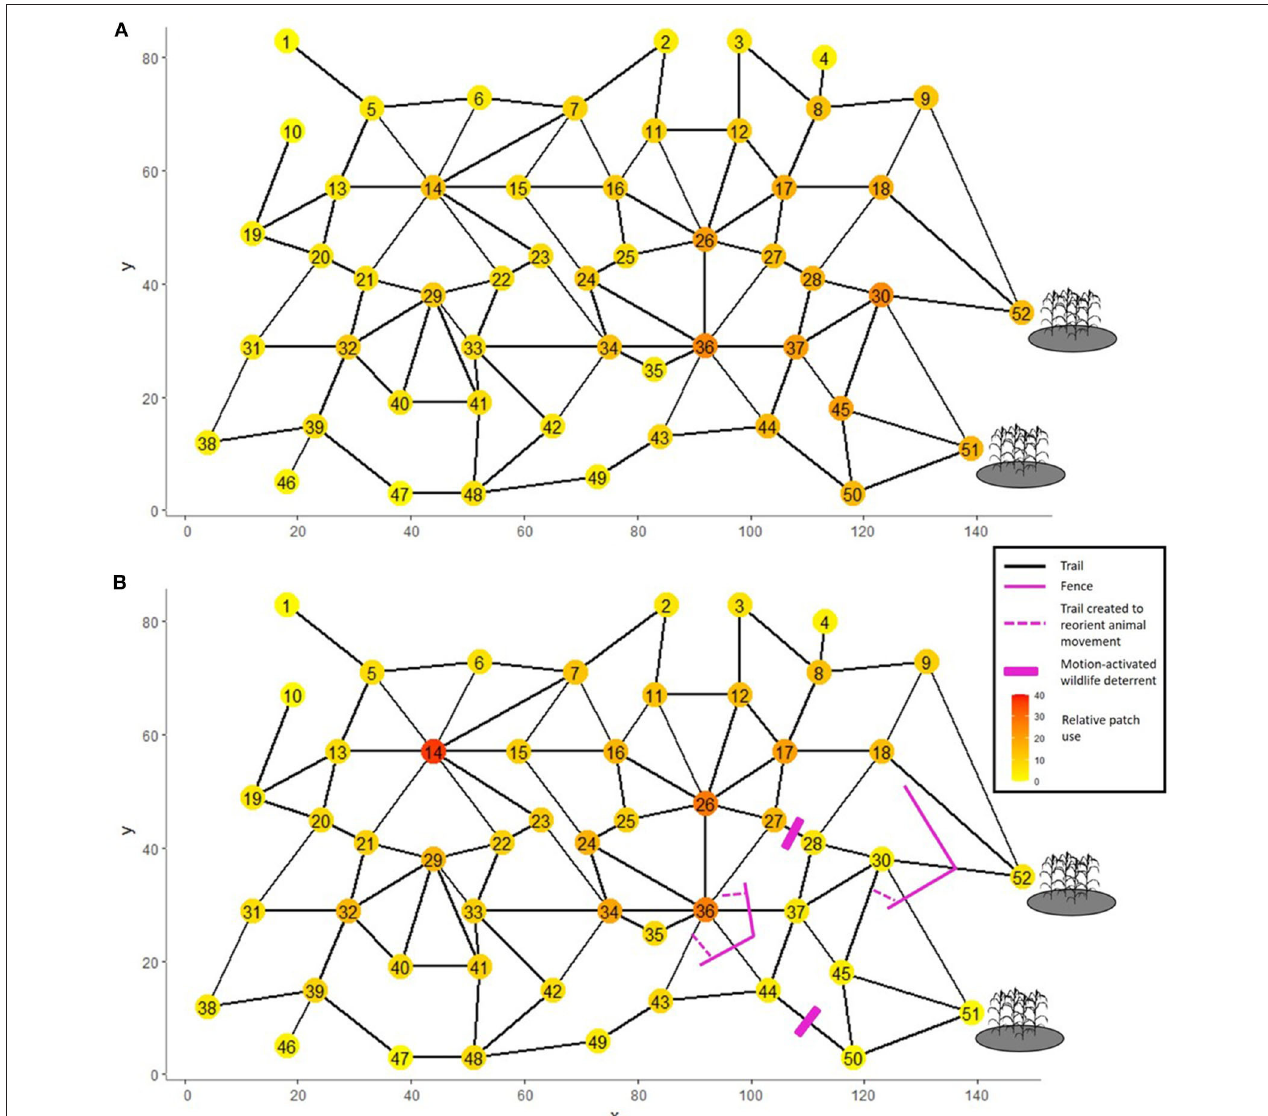
FIGURE 4 | Hypothetical spatial network comprised of 52 patches—including two agricultural patches where human-wildlife conflicts occur—connected by links (trails) with relative probability of travel given by Equation (9). (A) Relative patch use before any management intervention. (B) Relative patch use following five types of interventions: erecting fences, crating trails to reorient animal traveling along a fence, deploying motion-activated wildlife deterrent, adding resources in patch 14, and disturbing of animals to reduce their residency times in patches 51 and